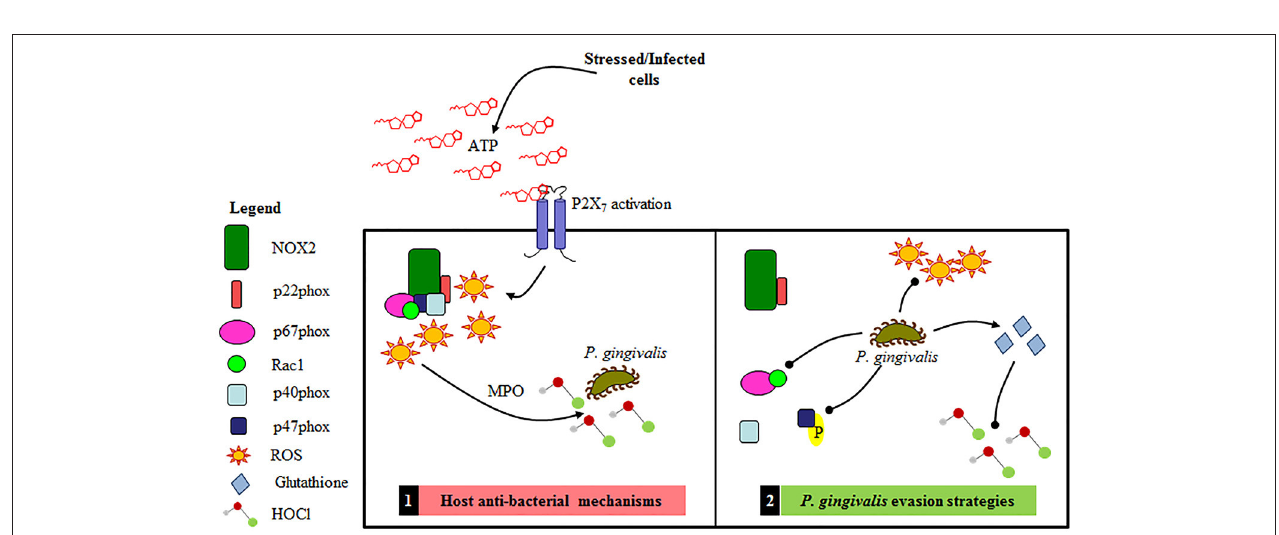
FIGURE 9 | Schematic representation of the proposed Gingival Epithelial Cell (GEC) anti-bacterial response and P. gingivalis’ specific evasions strategies of NOX2 antibacterial machinery. 1. Primary GEC host anti-bacterial mechanisms: NOX2-ROS is produced in response to eATP signaling leading to the production of HOCl and bacterial elimination. 2. P. gingivalis evasion strategies: P. gingivalis temporally blocks the formation of the NOX2 complex by affecting activation of critical cytosolic subunits and also diminishes ATP mediated HOCl production via the scavenging antioxidant